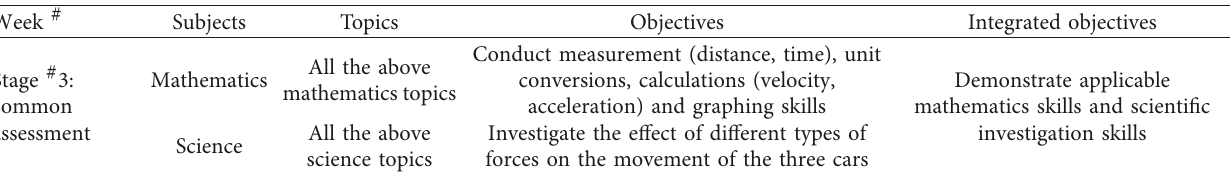
Table 3: Assessment